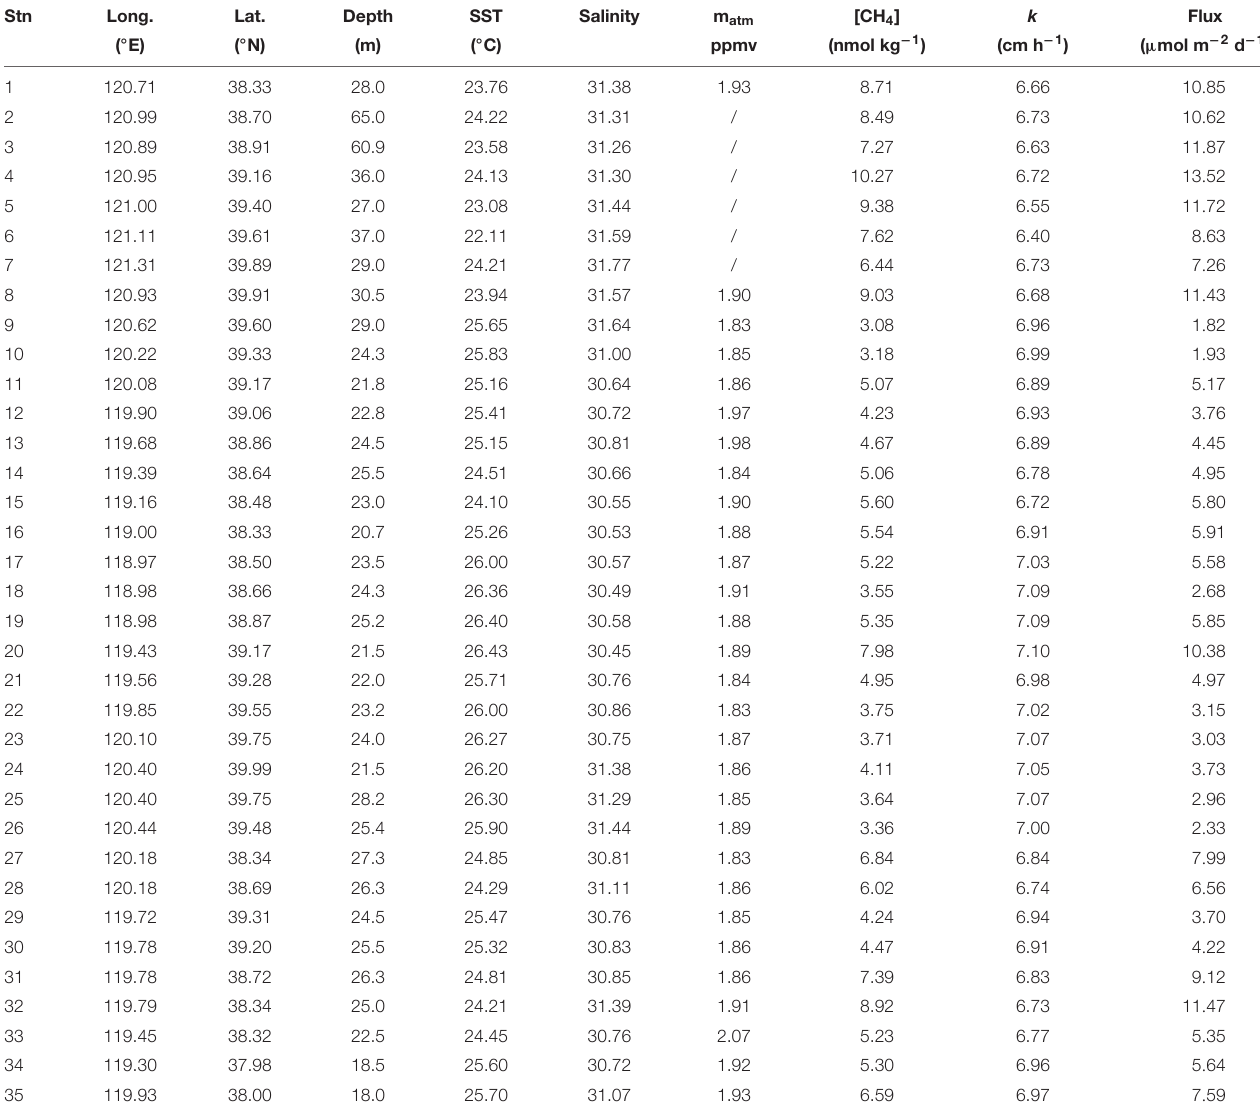
TABLE 1 | Locations of sampling stations with water depth, sea surface temperature (SST), salinity, atmospheric CH 4 mixing ratio (m atm ), [CH 4 ], air-sea exchange velocity ( k ), and sea-air flux. Stn